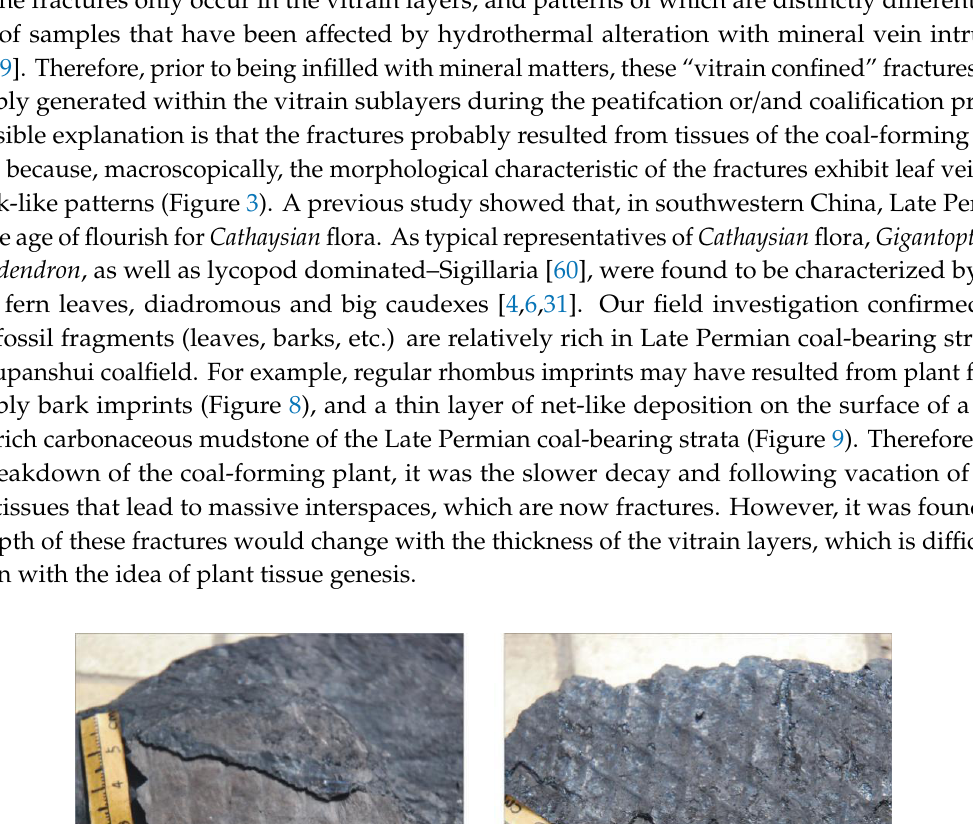
Figure 9. Fossil barks in a fossil plant-rich carbonaceous mudstone, Liupanshui coalfield. Another possible cause is that the fractures were of autogenetic genesis during the peatifcation or/and coalification process. As mentioned above, coals with this unique fracture are of banded structure, i.e., dark coal bands (vitrain layers) and light coal bands (clarain, durain and fusain layers), which appear alternately. Fractures only appear in the vitrain layers, implying that the vitrain layers are composed of different peat biomass from clarain, durain and fusain layers. This can be partly confirmed by the fact that the vitrain layer has a much higher volatile (38.50%) than that of the other parts (26.11%) (Table 2). In fact, a larger proportion of volatile matter means that the vitrain layer is prone to shrinking during the diagenesis process, which induces the fractures. However, the genesis